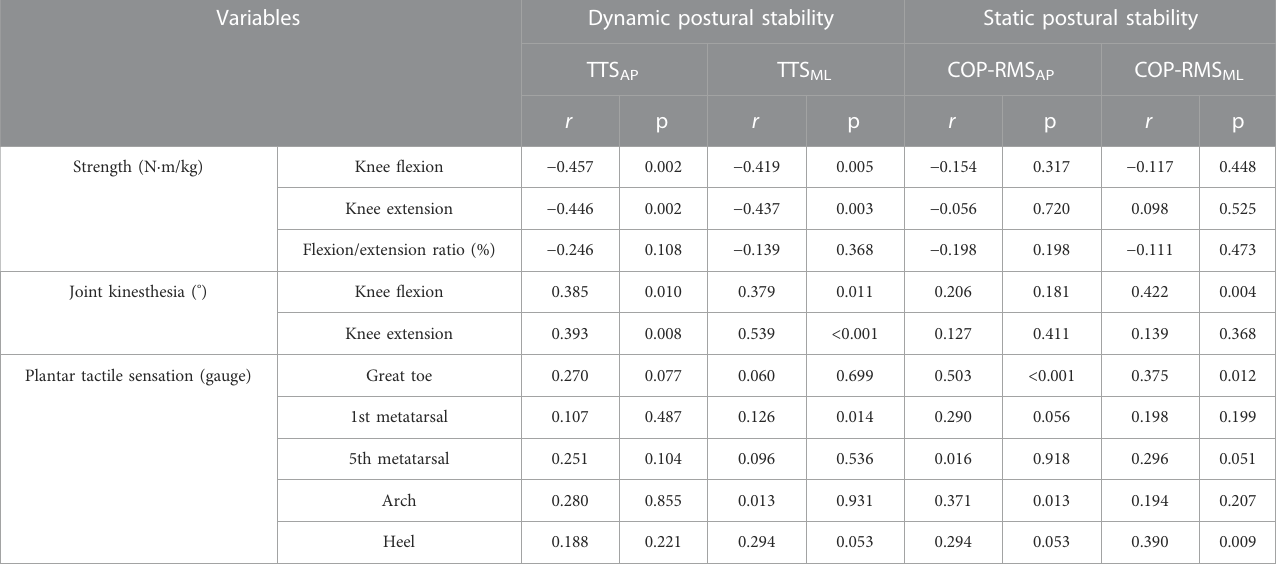
TABLE 2 Partial correlations of dynamic and static postural stability with strength, joint kinesthesia, and plantar tactile sensation.